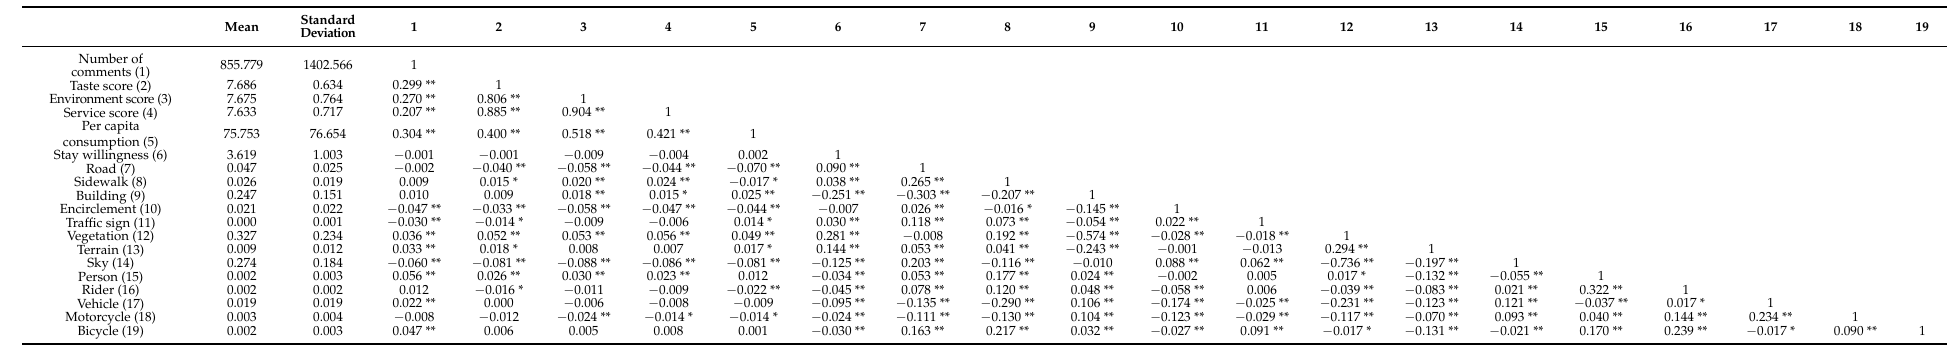
Table 4. Pearson’s correlation analysis